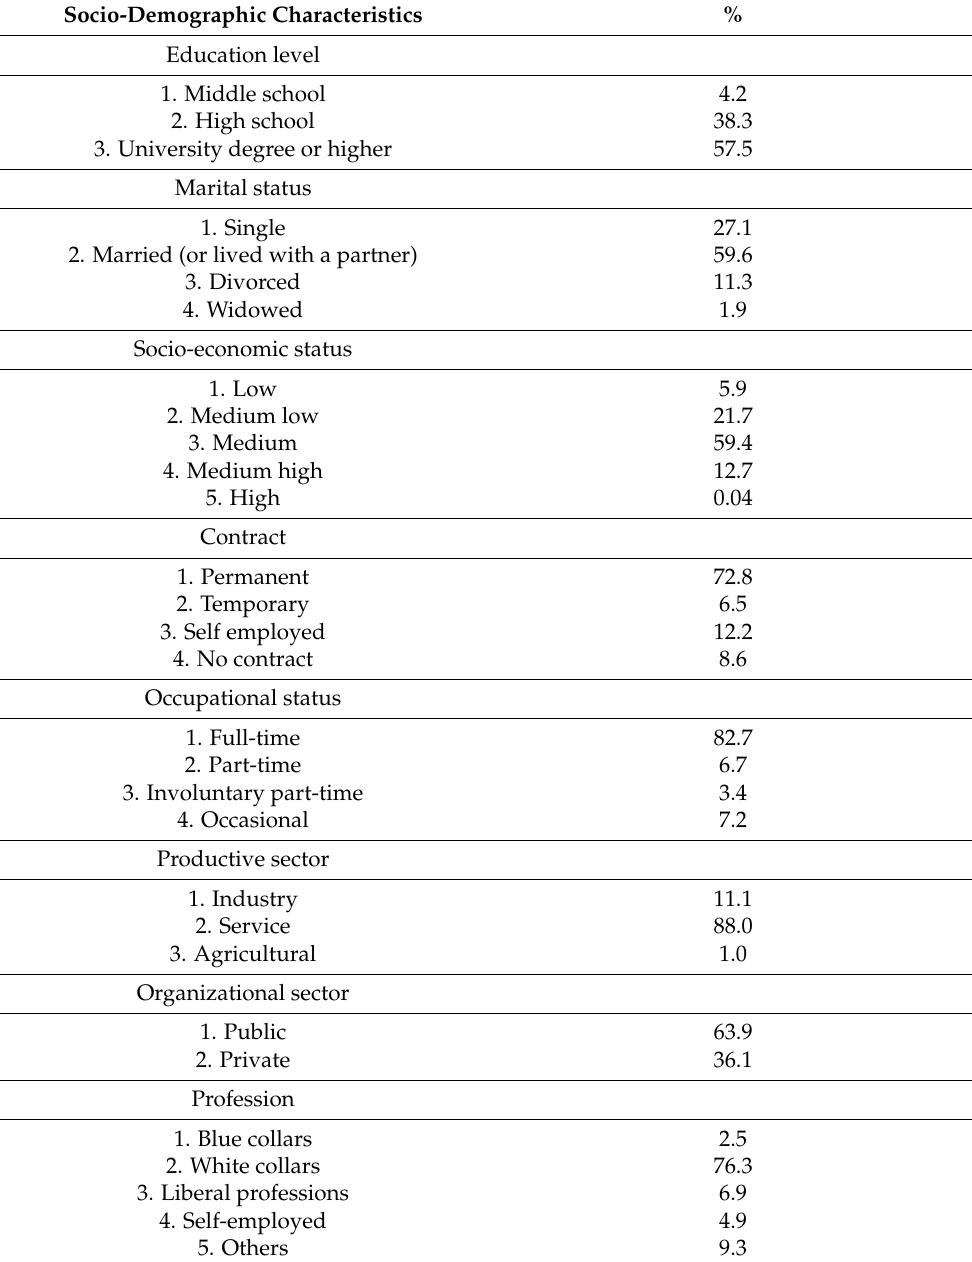
Table 2. Individual Characteristics of the Sample ( n =